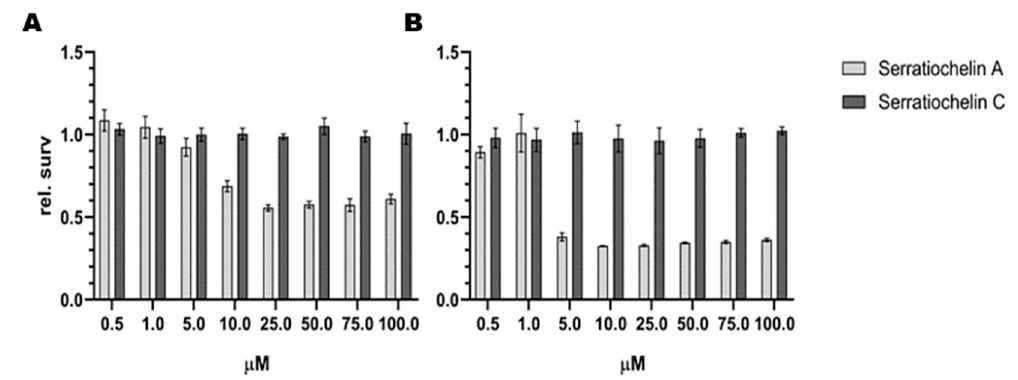
Figure 9. Antiproliferative effect of serratiochelin A ( 1 ) and C ( 2 ) on ( A ) A2058 (melanoma) and ( B ) MRC-5 (non-malignant lung fibroblasts) cell lines. The experiments were repeated twice with three technical replicates.